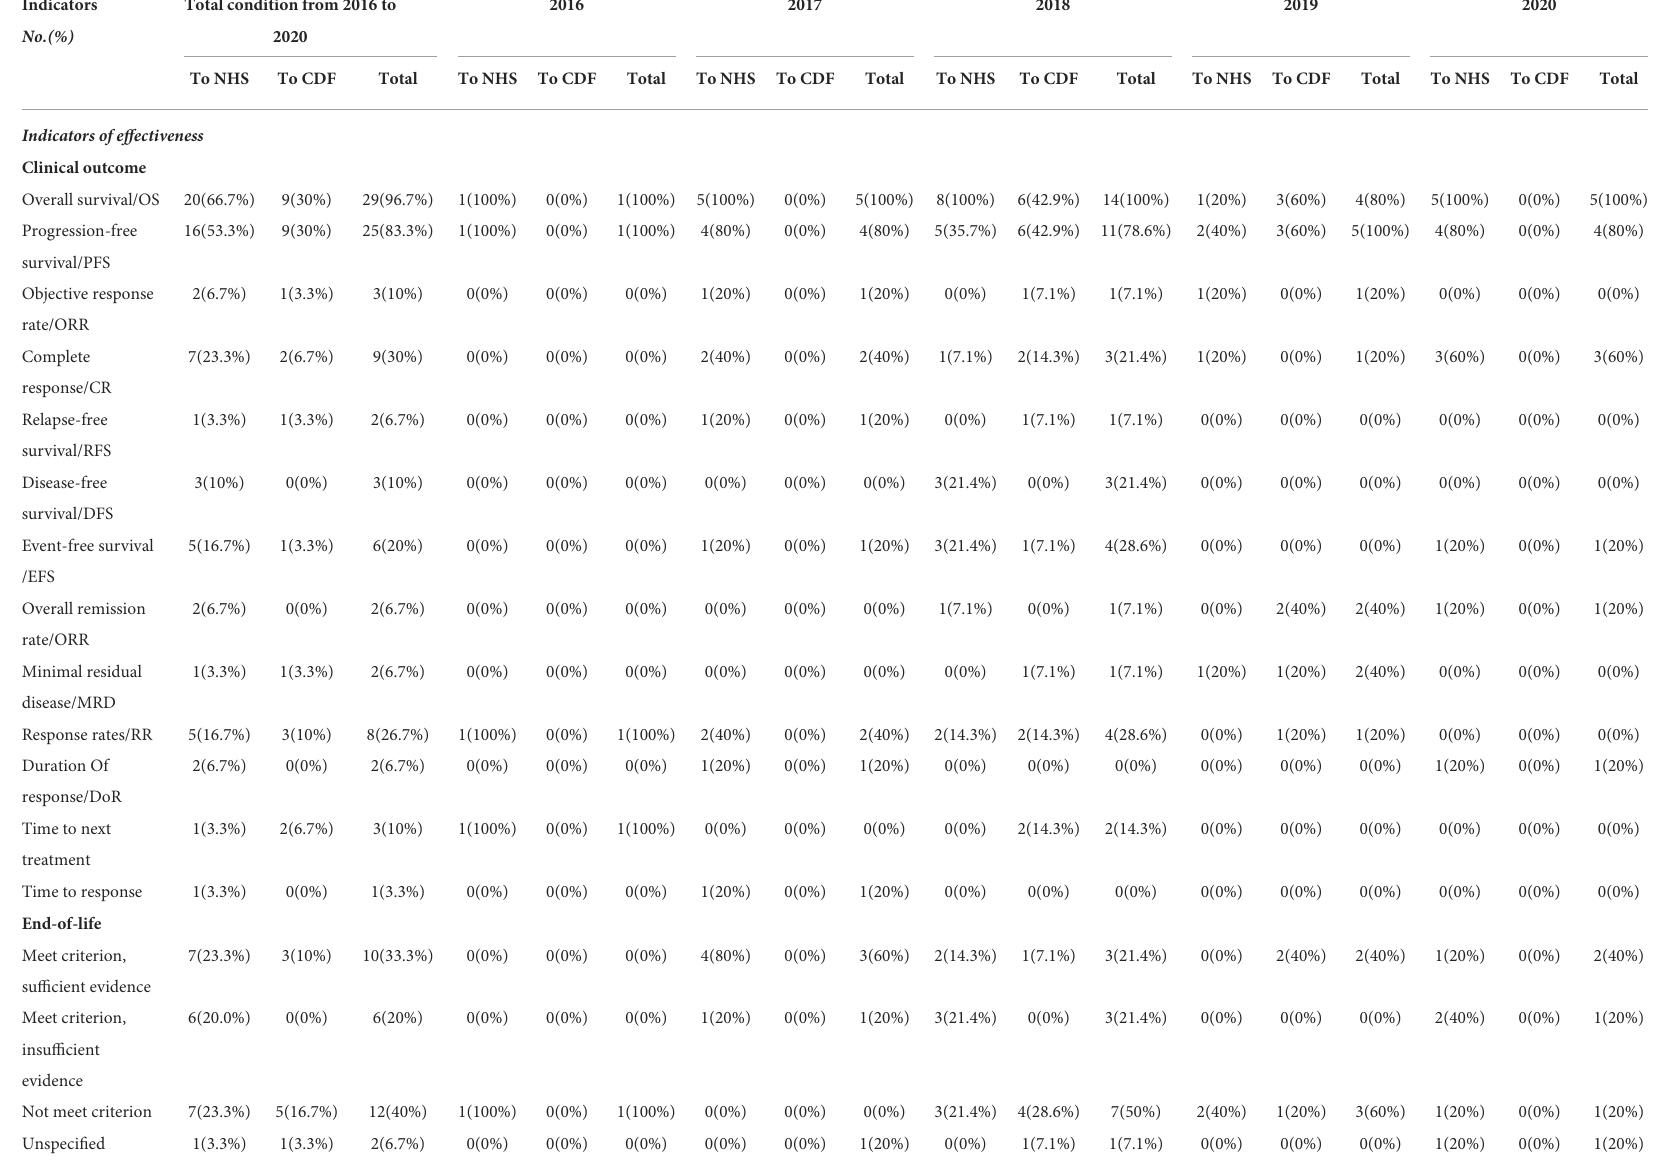
TABLE 4 Details of indicators of effectiveness in guidance from 2016 to